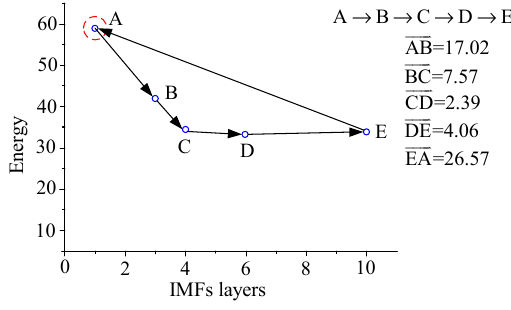
Figure 10. Shortest path of start node A.